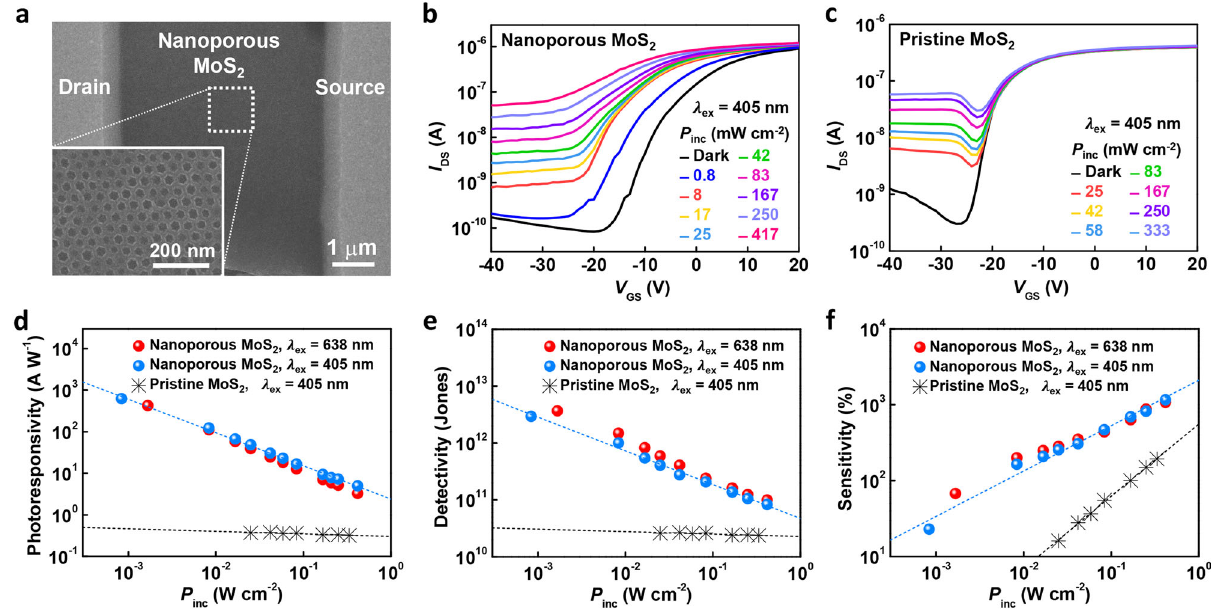
Fig. 4 Photoresponsive characteristics of the multilayer nanoporous MoS 2 TFTs. a SEM images of the nanoporous MoS 2 TFT. Transfer curves of b multilayer nanoporous MoS 2 and c pristine MoS 2 phototransistors in the dark and under illumination of λ ex of 405 nm for various P inc . d Calculated